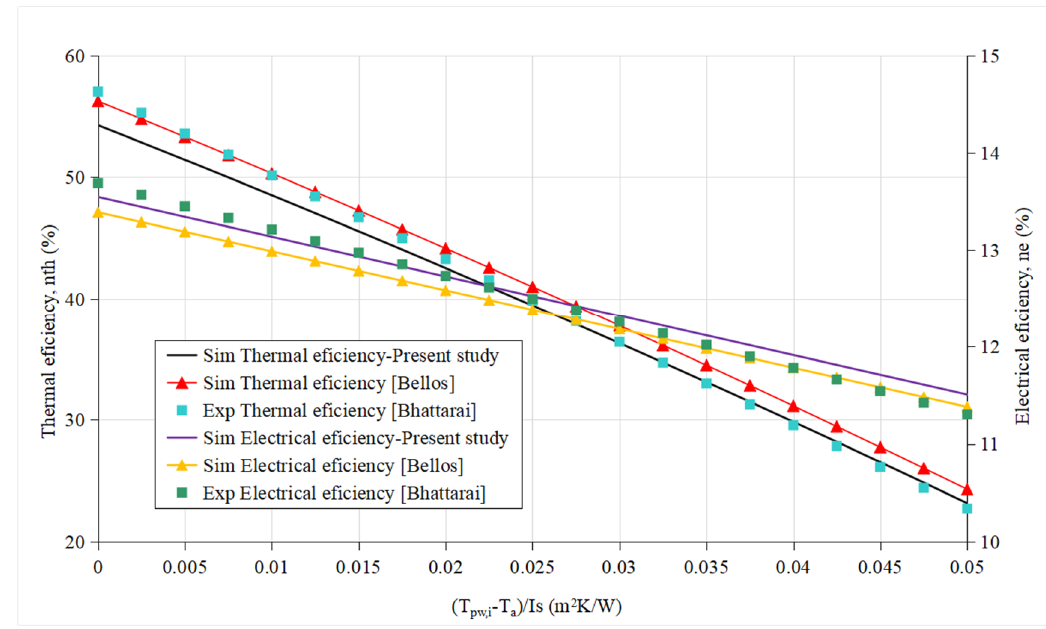
Figure 7. Comparison of the thermal-electrical efficiency of the research results with Bhattarai and Bellos. Table 2. Evaluation of